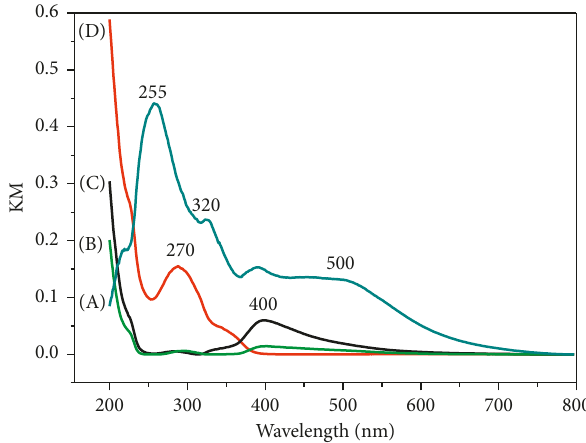
Figure 4: UV-Vis spectra of MnLUS (7wt.%) samples pre- pared with different methods of procedure (a) MnLUS DHT ,